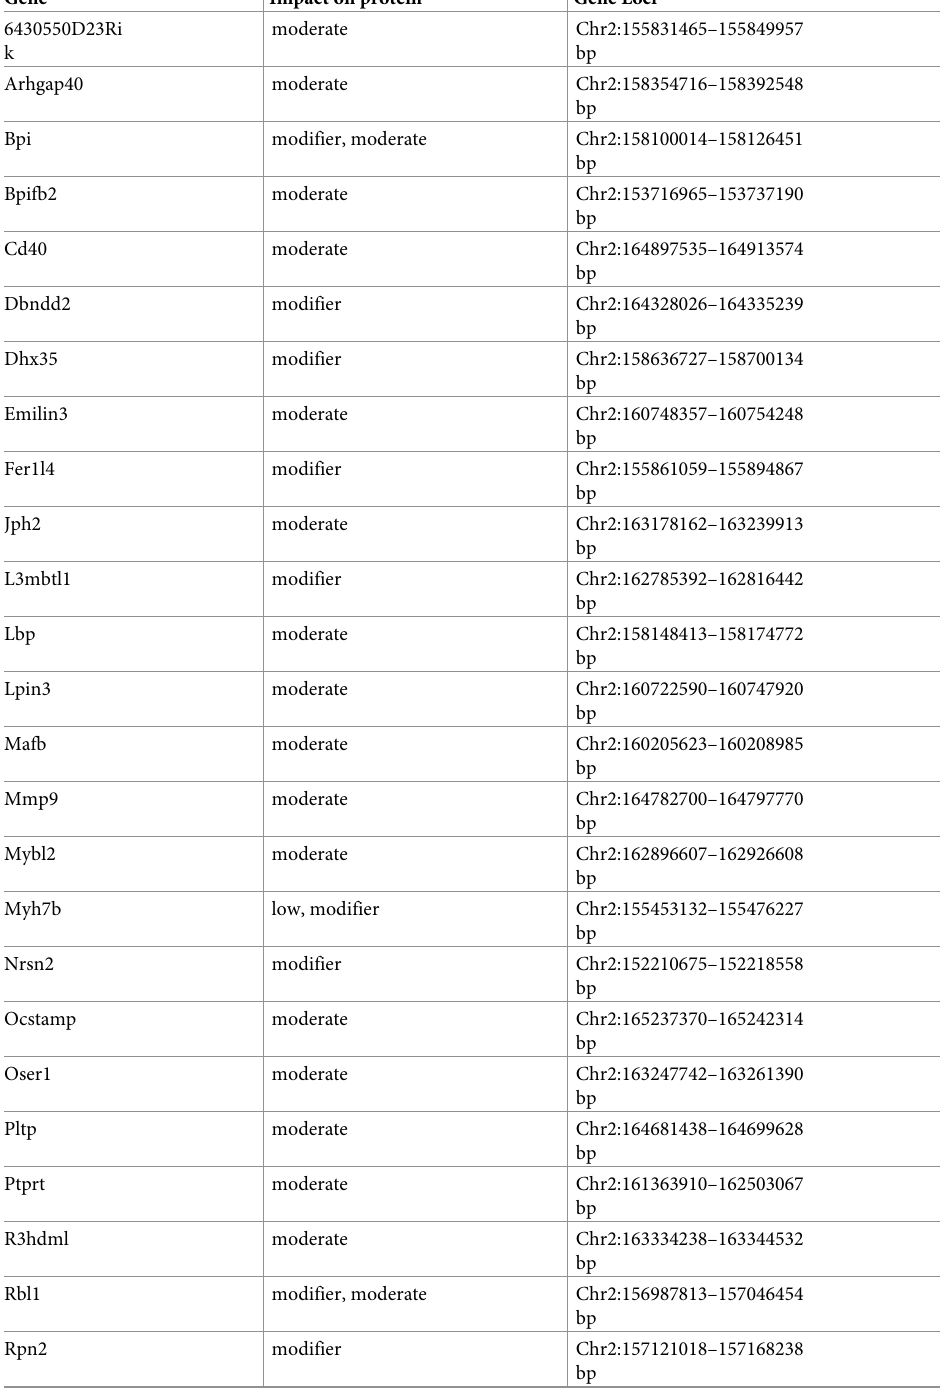
Table 3. Candidate genes from percent survived to day 7 QTL associations that had SNP differences correspond- ing to haplotype differences. The impact the SNP difference is predicted to have on the resulting protein is shown. “Moderate” are nondisruptive variants that might change protein effectiveness, “Modifier” are noncoding variant or a variant affecting a noncoding part of a gene, and “Low” are variants assumed to be unlikely to change protein behavior. Gene Impact on protein Gene Loci 6430550D23Ri moderate k Arhgap40 moderate Bpi modifier, moderate Bpifb2